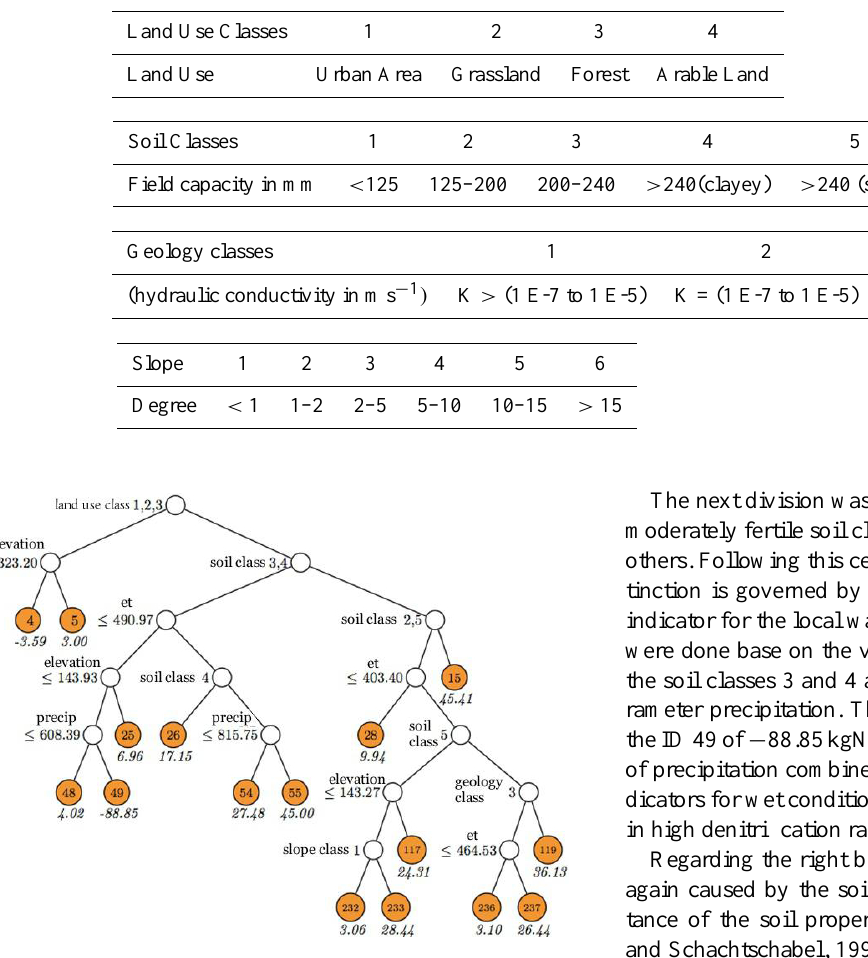
Table 2. List of categories of independent variables and classification criteria.